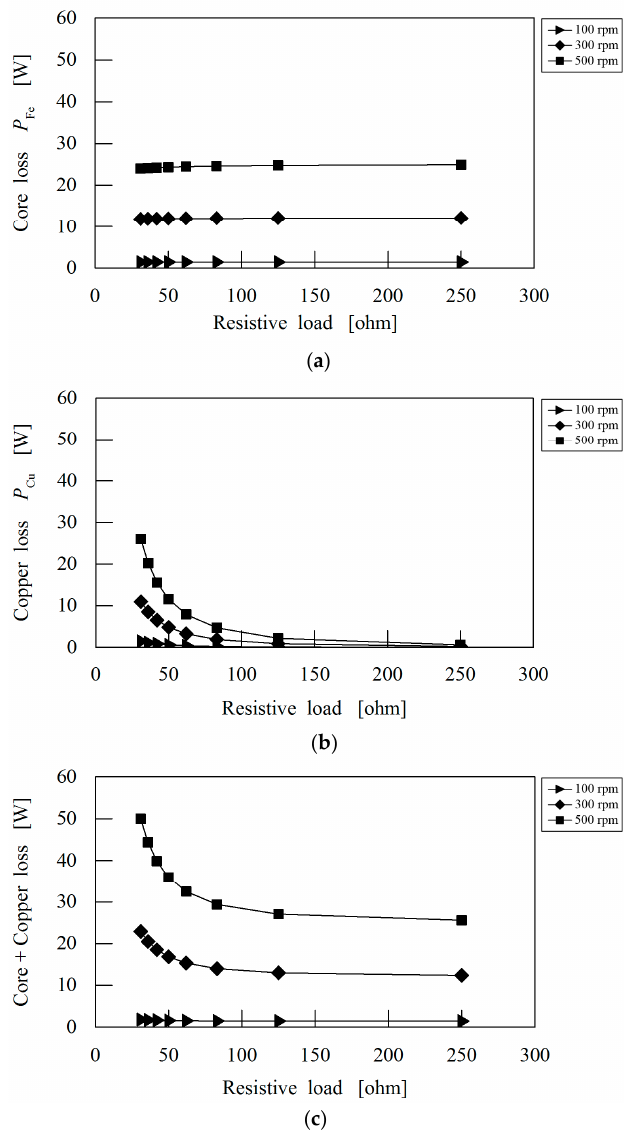
Figure 7. Core and copper losses as a function of resistive load at various speeds: ( a ) Core losses; ( b ) Copper losses; ( c ) Core and copper losses.